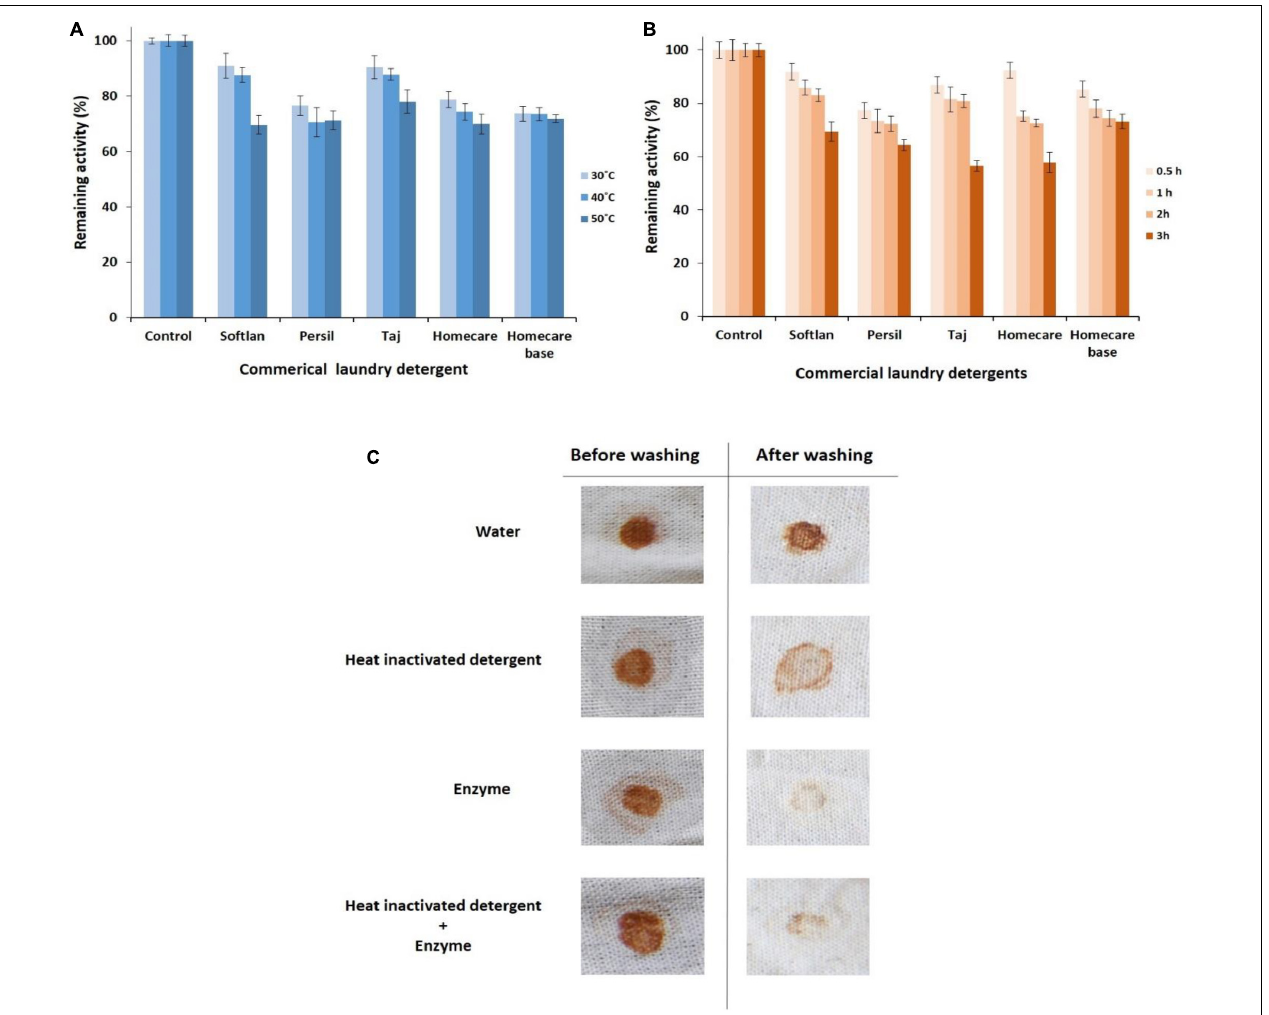
FIGURE 4 | Detergent compatibility study of the purified PersiAmy1. (A) Remaining activities after incubating in various temperatures (30, 40, and 50 ◦ C). (B) Remaining activities after incubating in various times (0.5, 1, 2, and 3 h). (C) Wash performance analysis of the purified PersiAmy1.